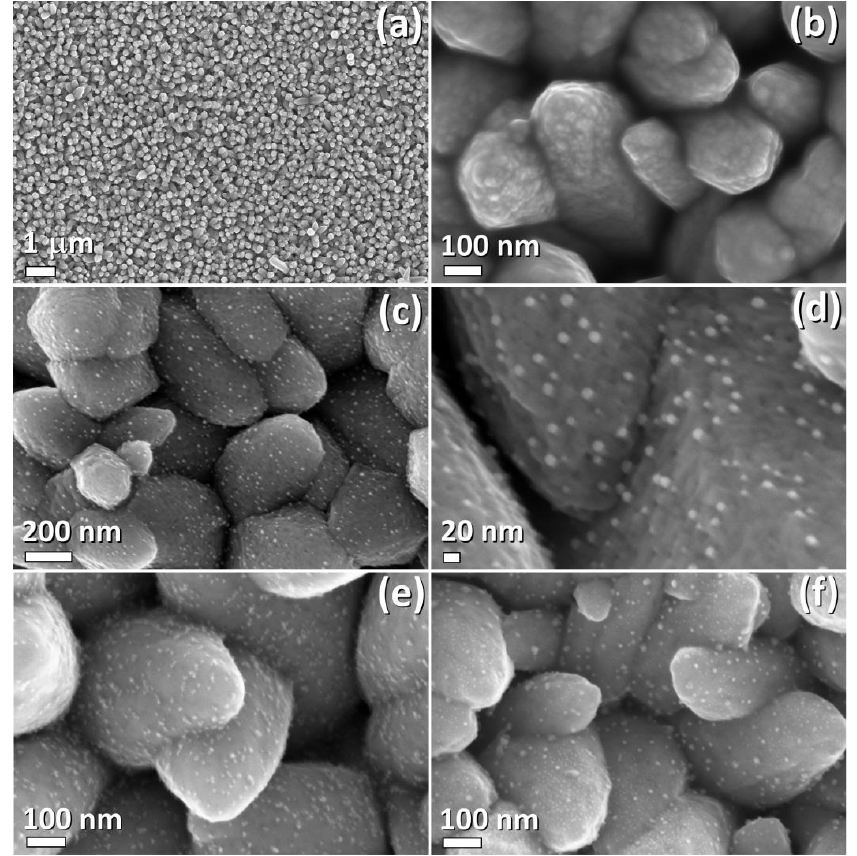
Figure 1. SEM images of ZnO:Ag nanostructured films: (a,b) pristine; (c,d) Ag NPs- functionalized; (e) AgPt NPs- functionalized; (f) AgAu NPs-